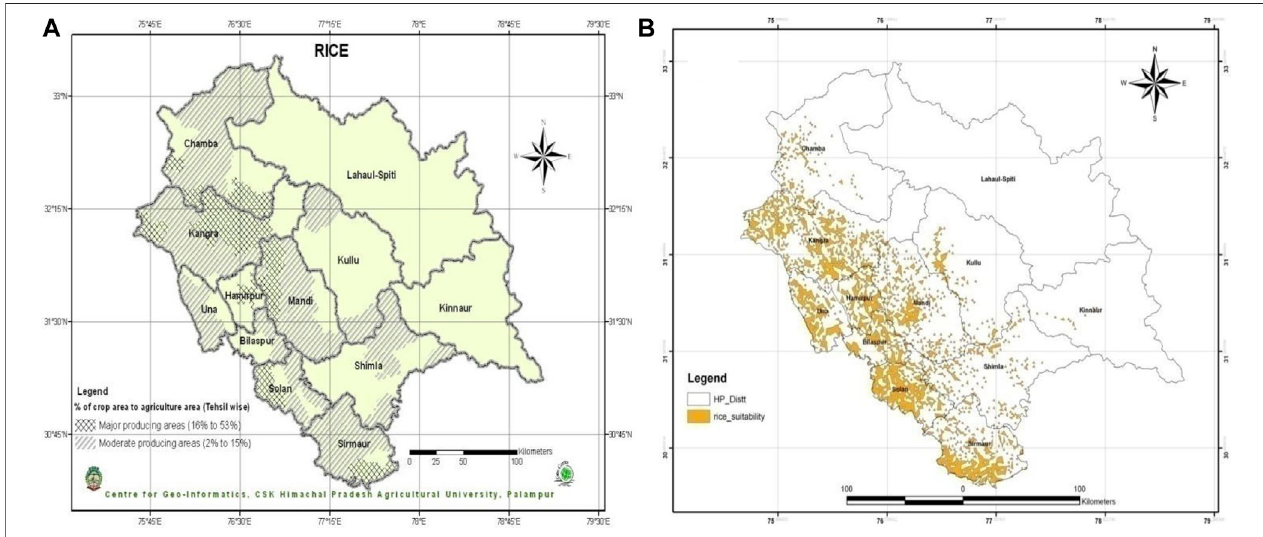
FIGURE 2 | Map of the Himachal Pradesh province of India showing (A) major/moderate rice producing areas and (B) rice suitability areas (Graphics Source: GIS Centre, CSKHPKV, Palampur, India).